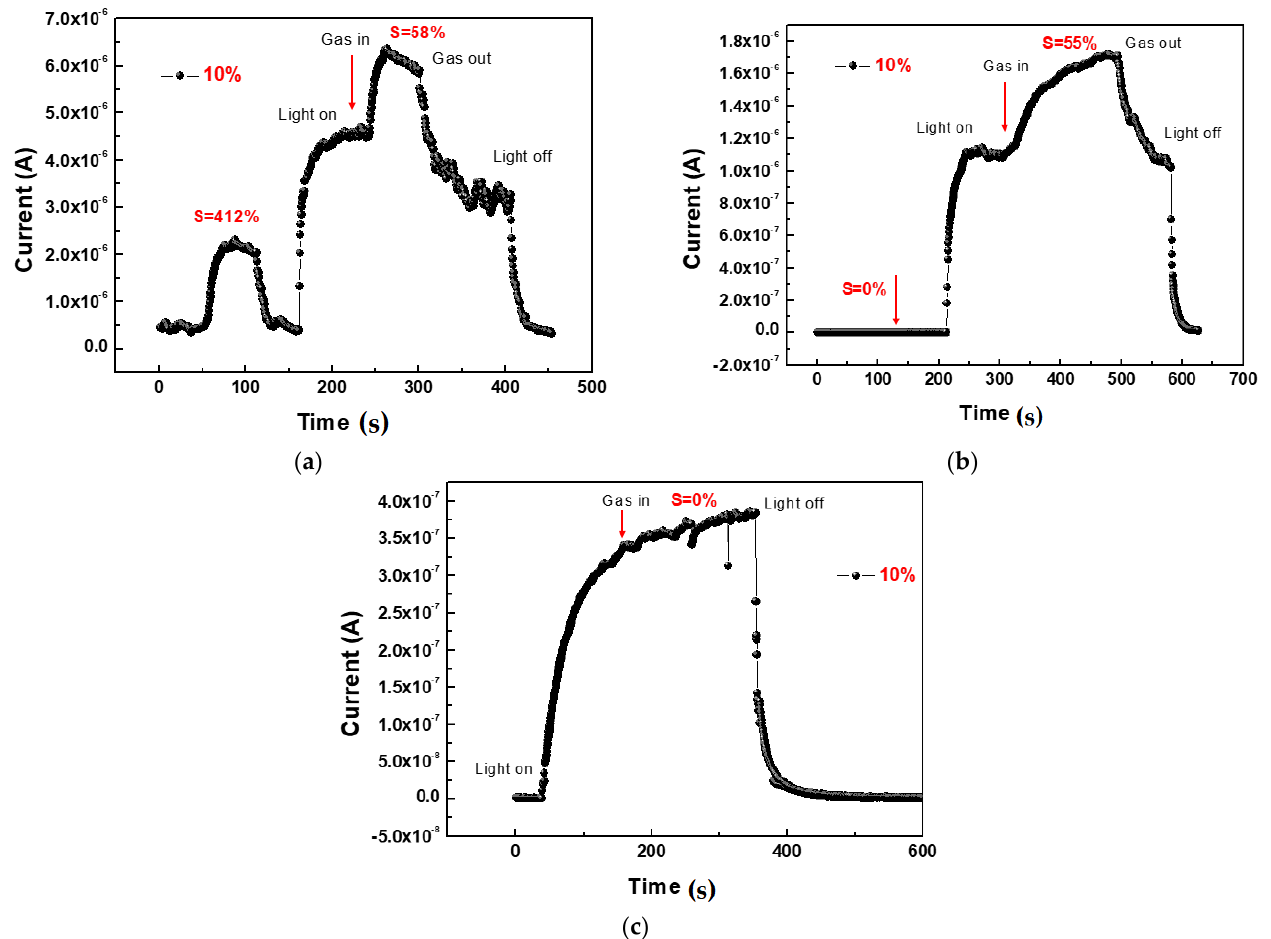
Figure 9. Current transient of 10% InTiZnO under 100 ppm ethanol at ( a ) 250 °C, ( b ) 150 °C, ( c ) 100 °C.